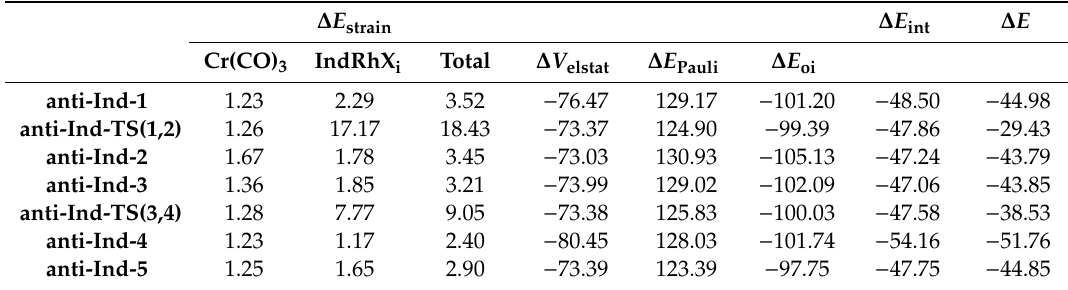
Table 3. Activation strain analysis (ASA) of all the intermediates and transition states of the anti-IndRh catalyzed cycle (Path I); all the values are in kcal mol − 1 . The fragments are Cr(CO) 3 and IndRhX i.